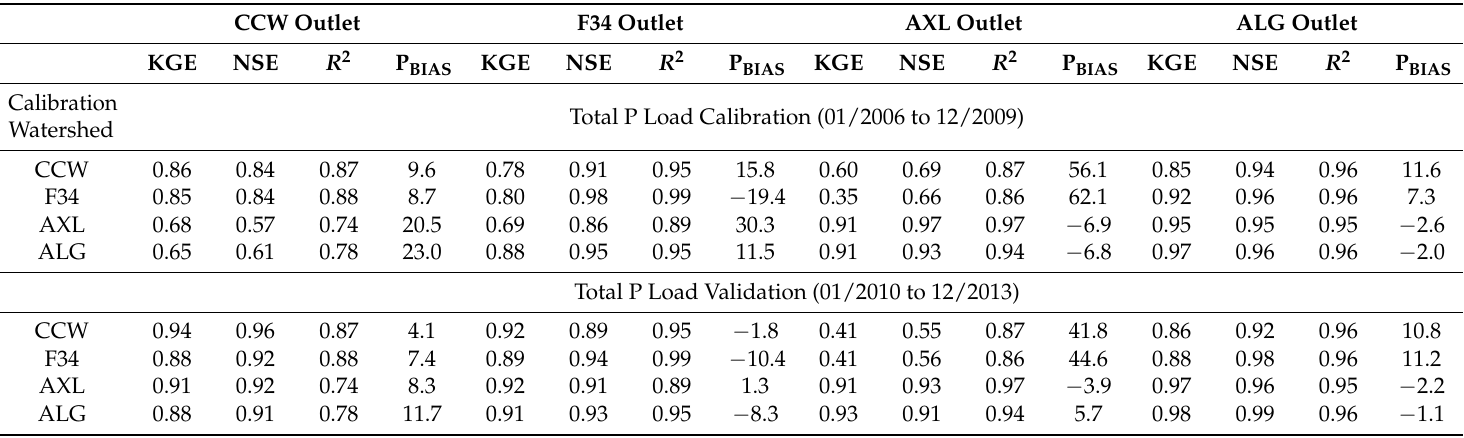
Table 12. Total P load calibration and validation statistical metrics for CCW, F34, AXL, and ALG SWAT model